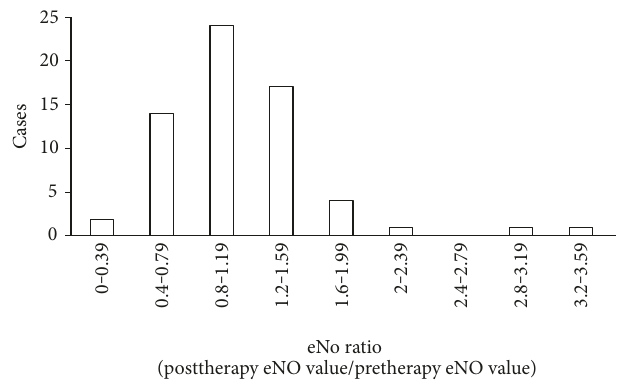
Figure 1: Changes of eNO of all 64